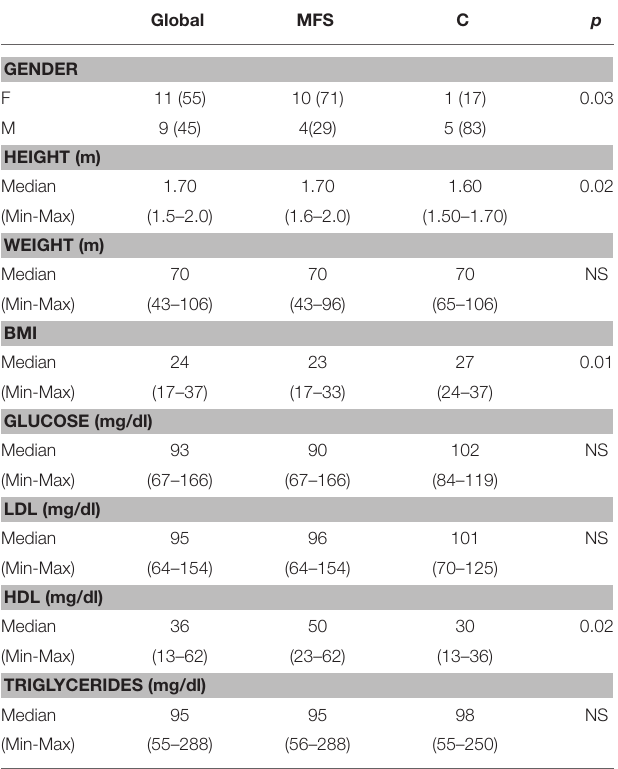
TABLE 1 | General demographic characteristics of patients with MFS and subjects